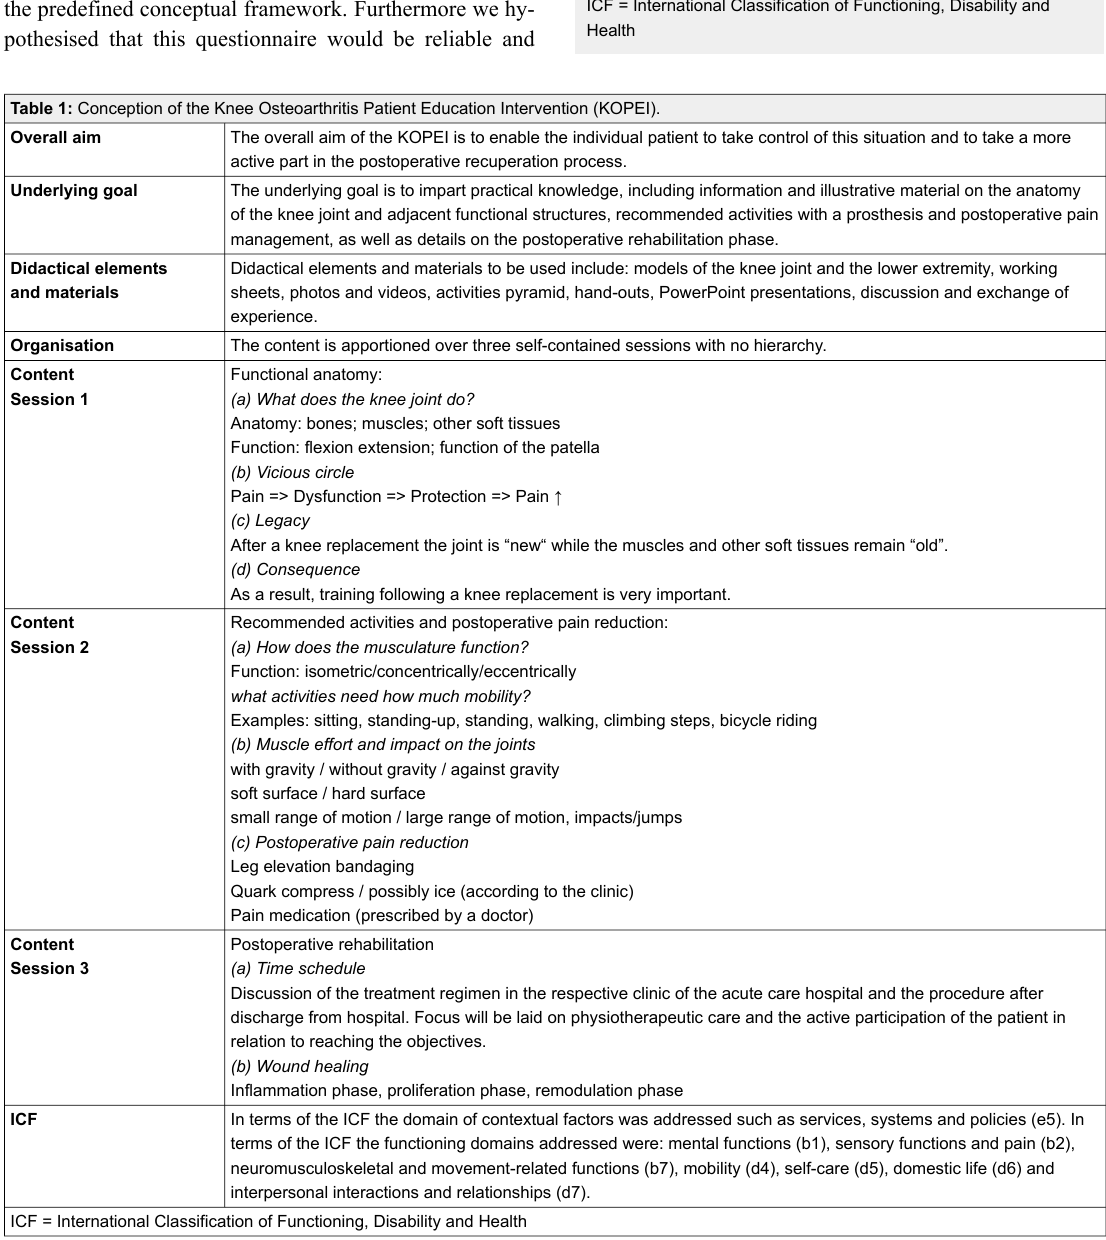
Conceptual framework of the Knee Osteoarthritis Patient Education Questionnaire (KOPEQ). ICF = International Classification of Functioning, Disability and Health